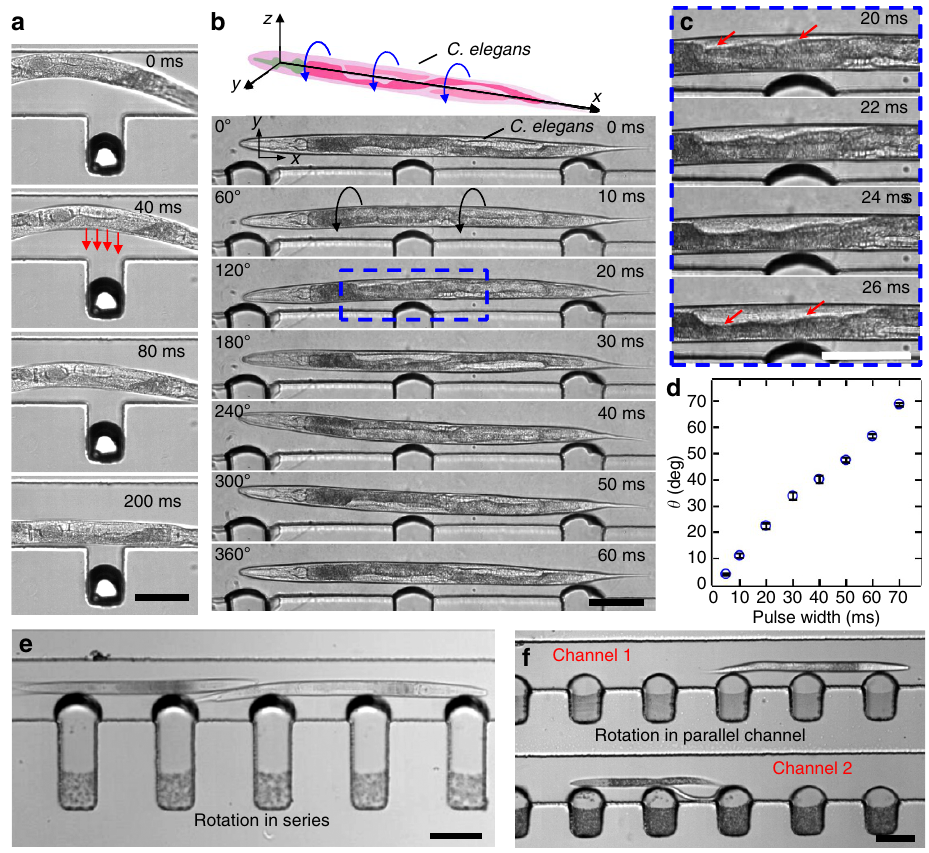
Figure 5 | High-speed images demonstrating trapping and rotation motion of C. elegans . ( a ) Image sequence demonstrate trapping of C. elegans by an oscillating bubble via acoustic radiation force. ( b ) The rotational motion of an L4 stage C. elegans caused by simultaneous oscillation of multiple microbubbles. ( c ) A rotation sequence of the boxed area at a tighter time resolution. ( d ) Plot of the rotational angle y versus a function of time t for a C. elegans . Error bars represent standard deviation ( n Z 5). Scale bars, 100 m m. Trapping and rotation of multiple worms ( e ) in series arrangement in a channel and ( f ) in parallel arrangement in multiple